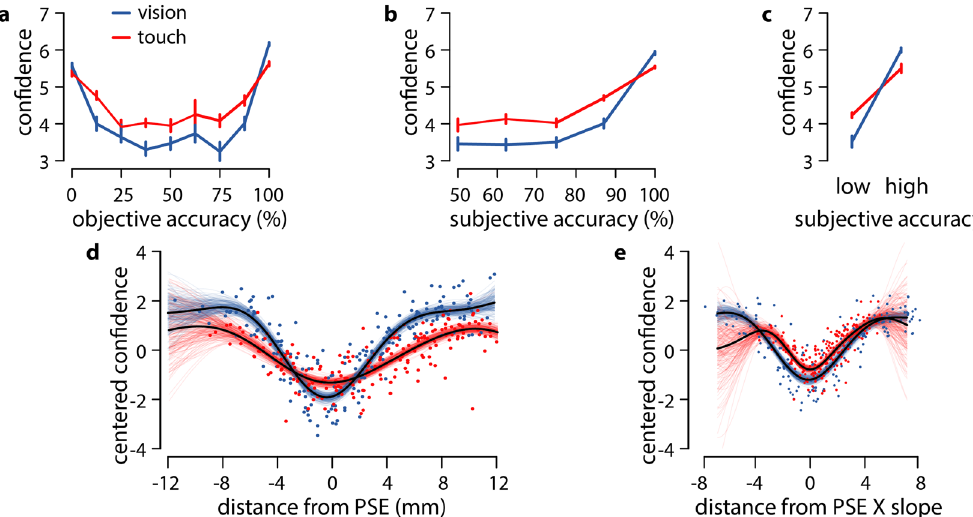
Figure 3. Objective and subjective accuracy. ( a ) Confidence vs. objective accuracy. ( b ) Confidence vs subjective accuracy. ( c ) Subjective accuracy collapsed into low and high levels. ( d ) Confidence ratings on individual trials, relative to that observer’s mean rating, as a function of distance from PSE. Confidence depended on modality, and the distance of the vertical bars’ length from PSE. Confidence is greater in touch for bars close to PSE, and greater in vision for bars far from PSE. Thin lines show samples from the posterior distribution of Gaussian processes describing the relationship between confidence and bar length. Thick lines show maximum a posteriori functions. Confidence is greater in touch than vision for stimuli close to PSE, but greater in vision otherwise. ( e ) Confidence ratings individual trials as a function of normalised distance from PSE - distance from PSE, multiplied by that participant’s psychophysical slope in that modality. Confidence is higher in touch than vision for stimuli within 3 standard deviations of